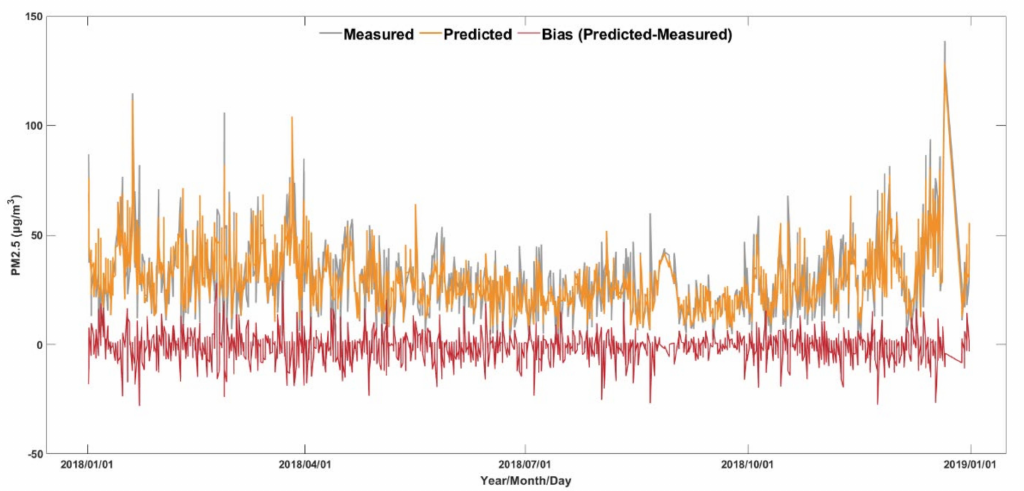
Figure 7. Time series plot of estimations from the STBT model and measurements together with bias between estimations and measurements. The abscissa represents the time of two hours before and after 12:00 local time, and the ordinate represents the average of the observed values of all stations in that hour.